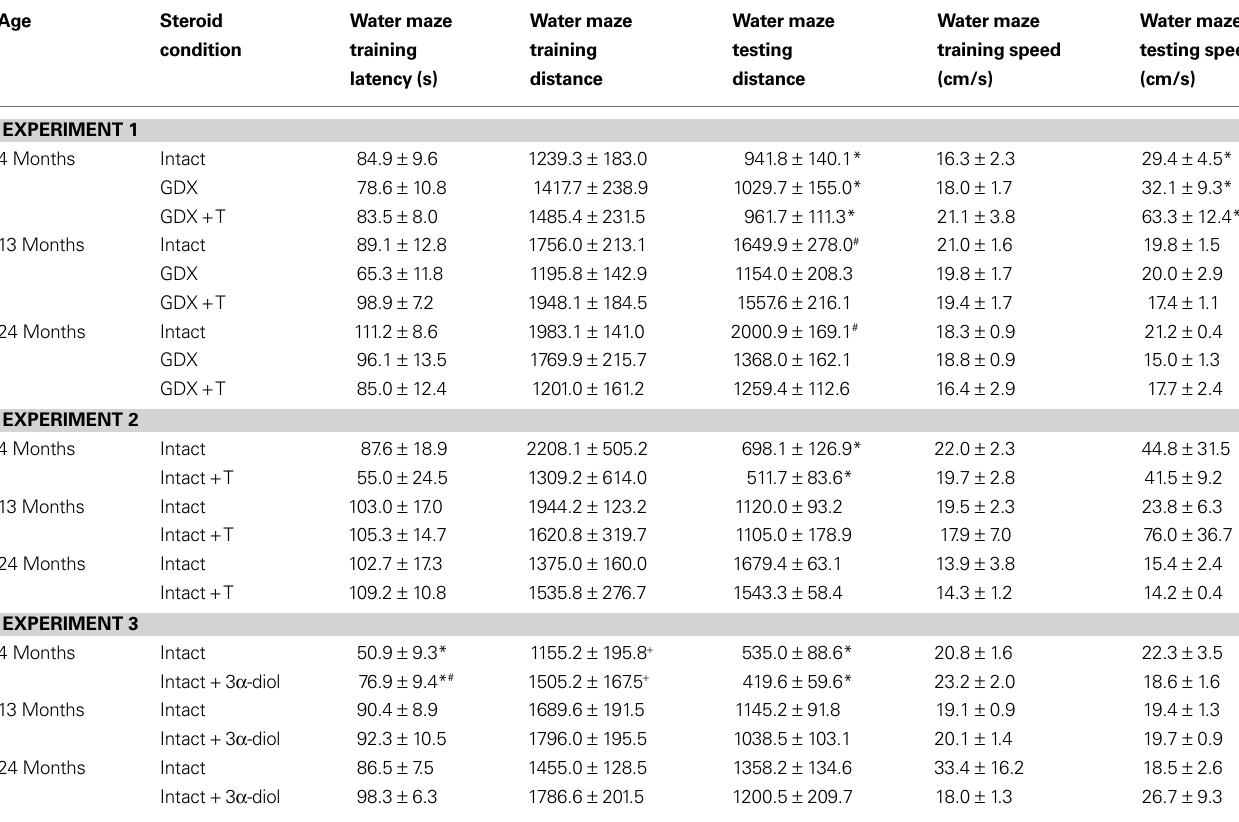
Table 2 | Other measures in the water maze tasks of 4-, 13-, and 24-month-old gonadally-intact (intact), gonadectomized (GDX), or GDX and T-replaced (GDX + T; Experiment 1), intact and T-administered (Experiment 2), and intact or intact or intact and 3 α -diol-administered (Experiment 3) rats. Measures are: latency, swim speed, and distances traveled during training in the water maze (mean ± SEM averaged over two trials) and swim speed and distances traveled during testing (mean ± SEM averaged over four